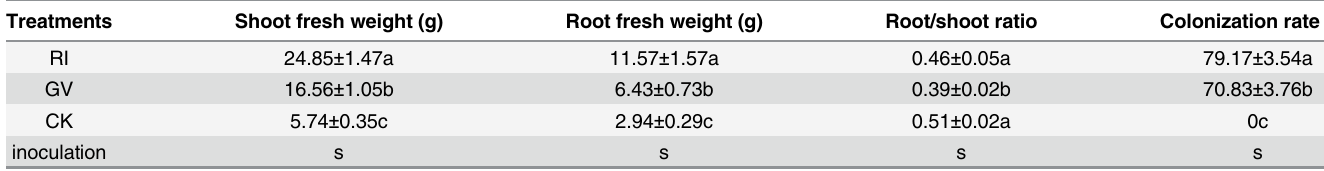
inoculation s, signi fi cant at P = 0.05, n = 6; Value with different letter indicated signi fi cant difference (Fisher ’ s LSD-test P = 0.05, n = 6); RI, inoculated with R . irregularis ; GV, inoculated with G . versiforme ; CK, without inoculation. Replicate data is from S1